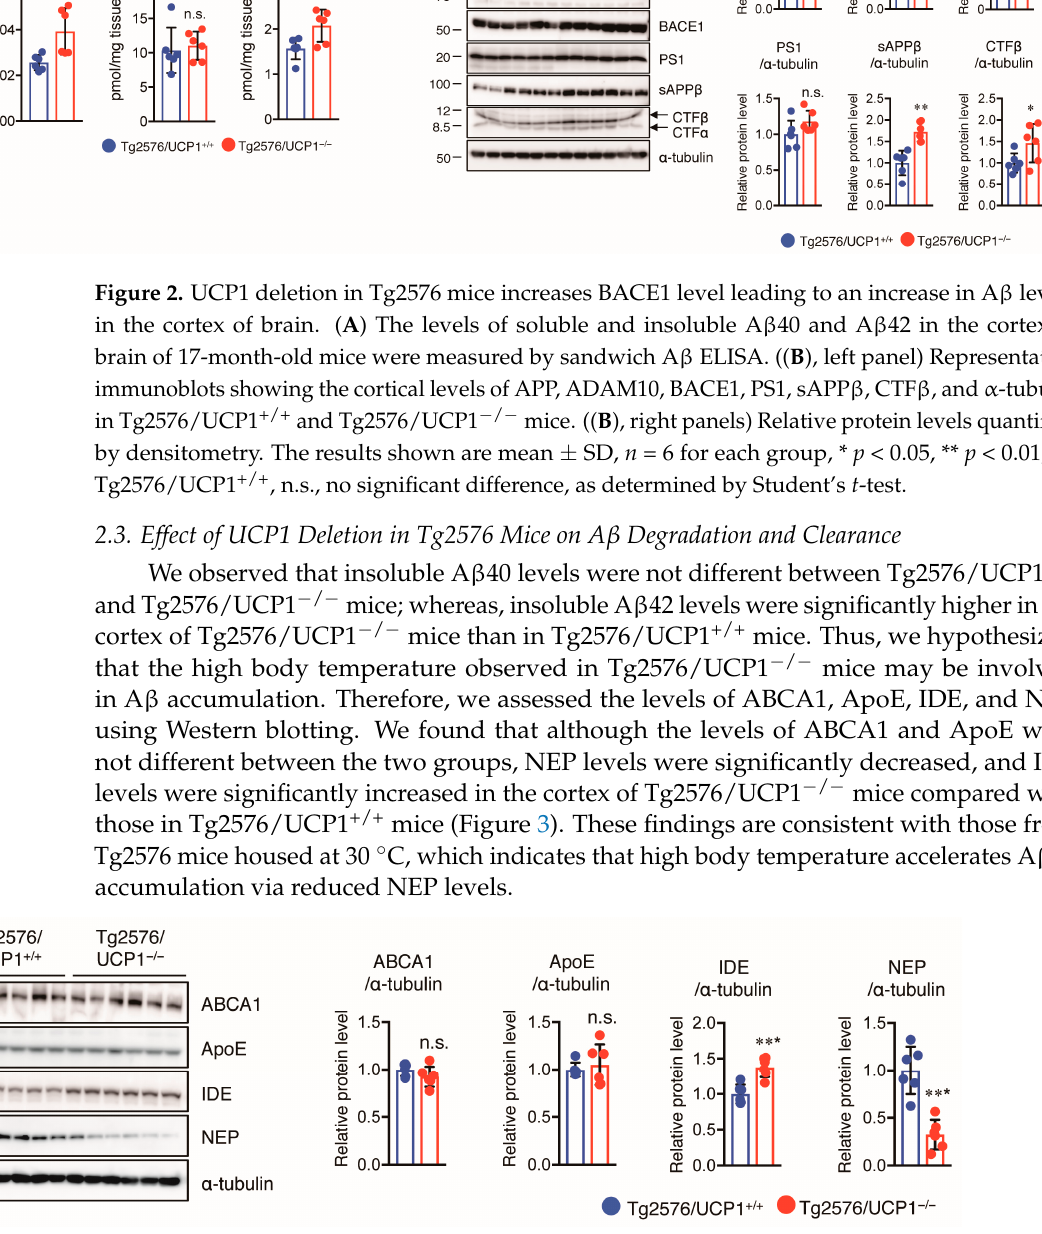
Figure 3. UCP1 deletion in Tg2576 mice increases IDE levels and decreases NEP levels. Representative immunoblots showing the cortical levels of ABCA1, ApoE, IDE, NEP, and α -tubulin in 17-month-old Tg2576/UCP1 +/+ and Tg2576/UCP1 − / − mice (left panel). Relative protein levels quantified by densitometry (right panels). The results shown are mean ± SD, n = 6 for each group, *** p < 0.001, vs. Tg2576/UCP1 +/+ , n.s., no significant difference, as determined by Student’s t -test. Aggregation and hyperphosphorylation of tau crucially contribute to AD